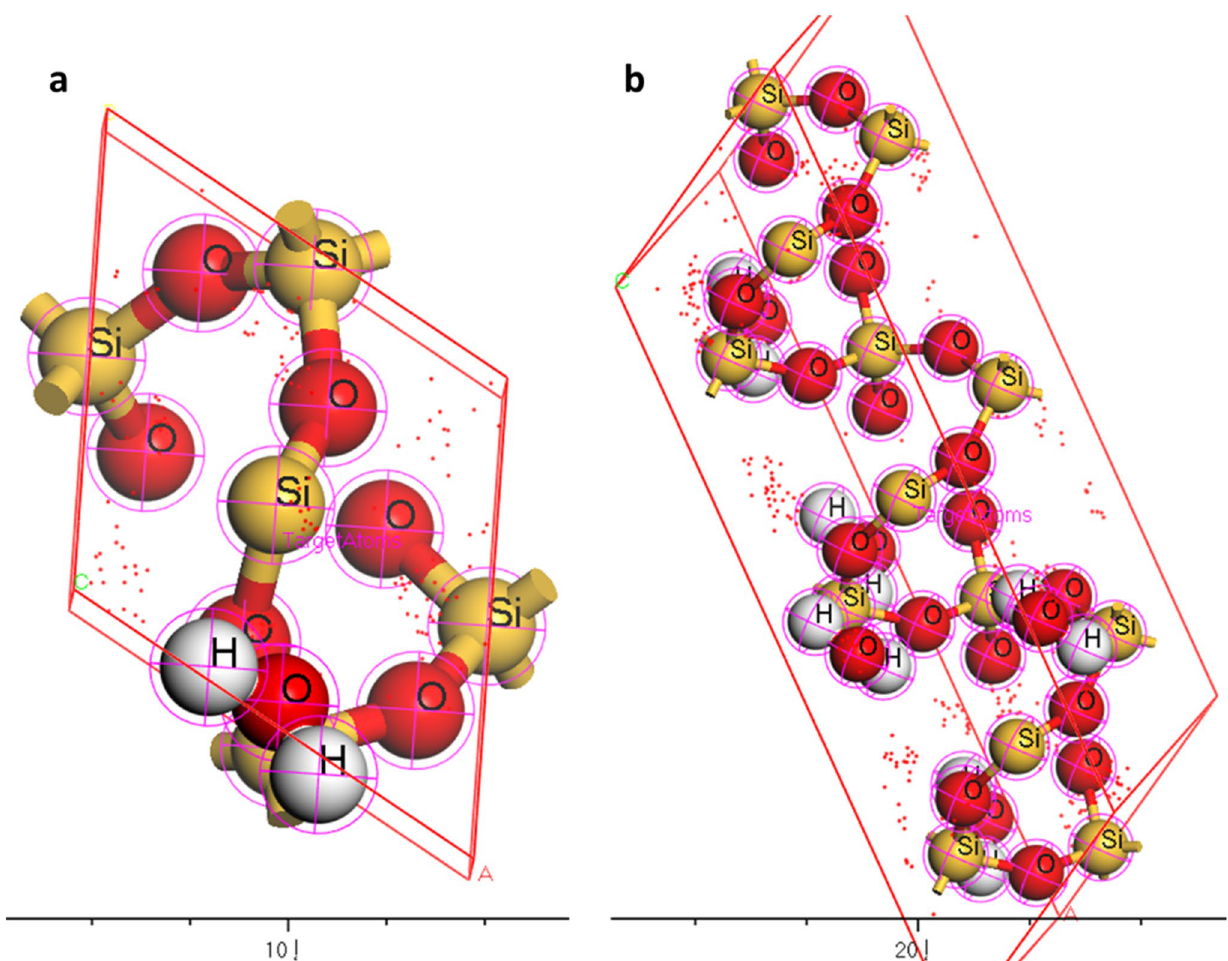
Fig. 7 Optimized geometry of NaOH adsorbed on quartz, with the red dots denoting the NaOH adsorbates